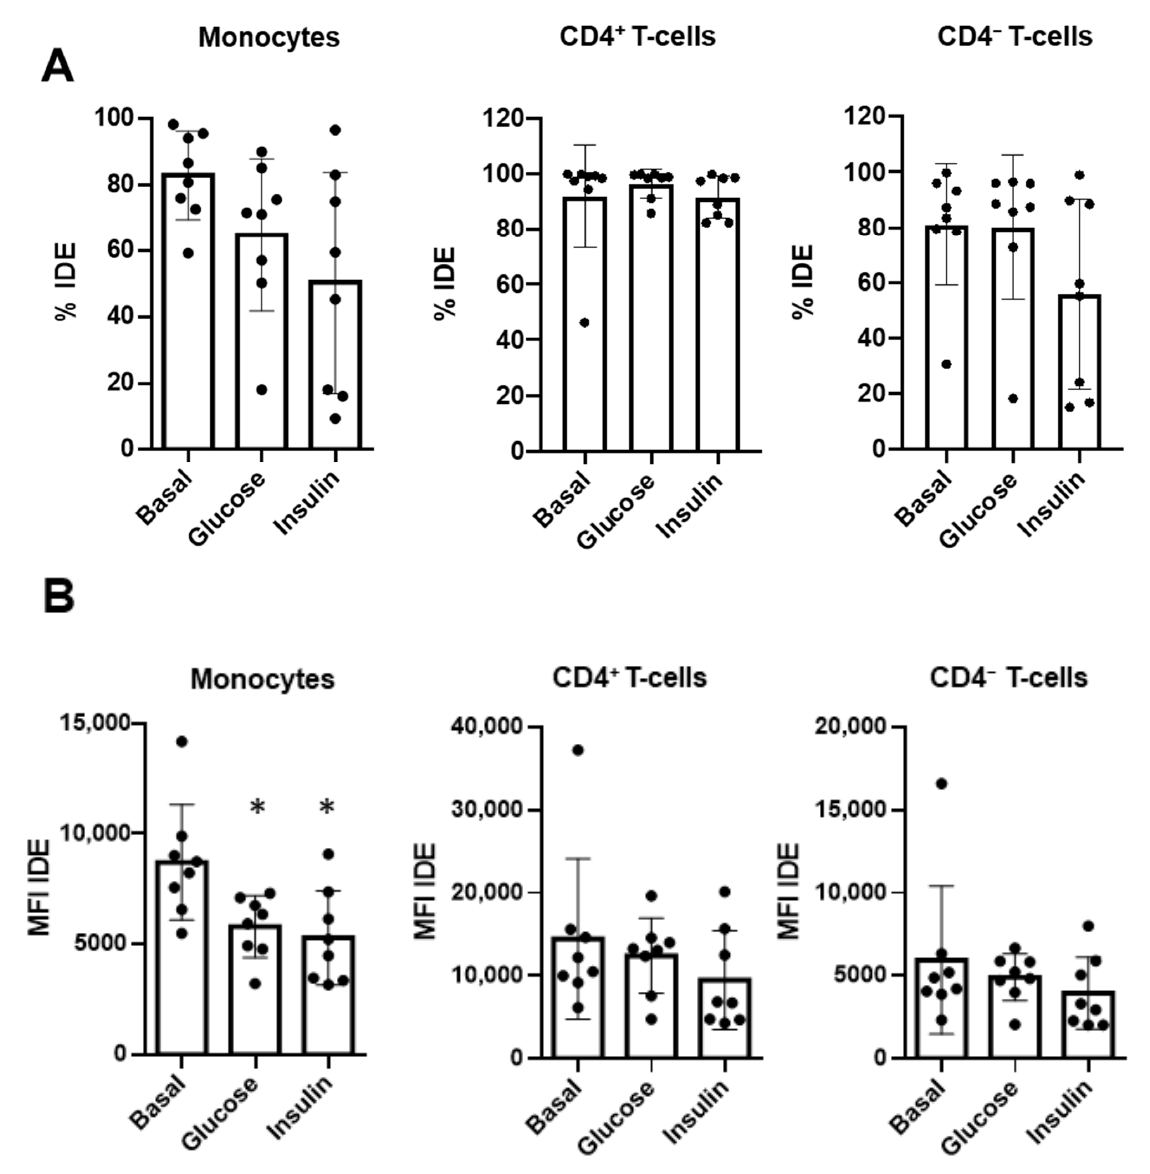
Figure 6. IDE surface expression on monocytes is modulated by glucose and insulin. Peripheral blood mononuclear cells from healthy controls were ex vivo cultured in resting conditions (basal), in the presence of glucose (22 mM), or in the presence of insulin (2500 pmol/L). IDE expression, determined both as a percentage ( A ) and as the median fluorescence index (MFI) ( B ) on monocytes, B-cells CD4 + T-cells, and CD4 − T-cells, was assessed as in Figure 2. One-way ANOVA repeated measures with a Dunnet correction were applied following ad hoc comparisons to the basal culture. * p <